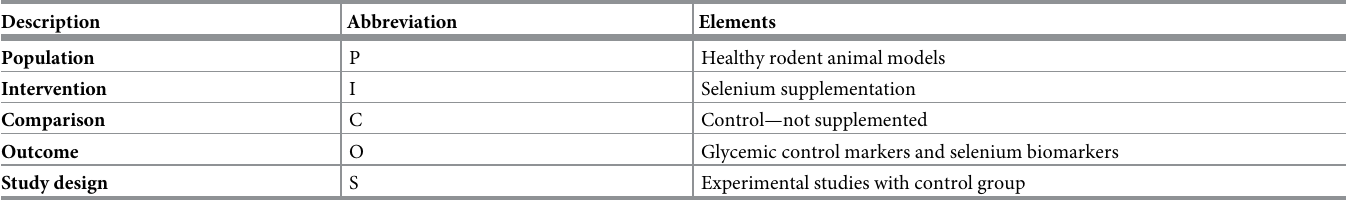
Table 1. Definition of the structured review question in the form of the acronym